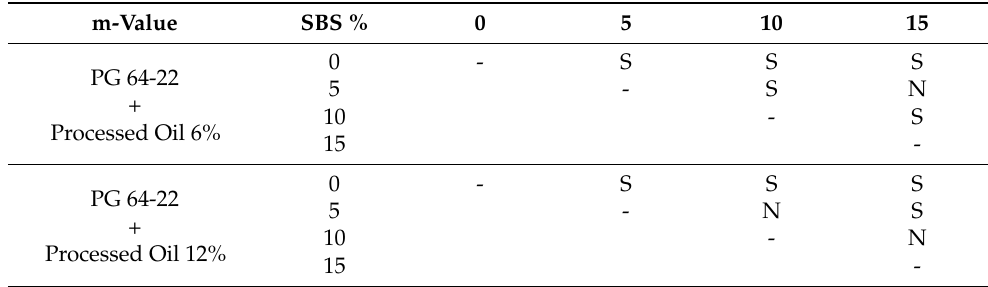
Table 14. Statistical analysis results of m-value for RTFO + PAV aged PG 64-22 with processed oil as a function of SBS content − 24 ◦ C ( α = Table 13. Statistical analysis results of m ‐ value for RTFO + PAV aged PG 64 ‐ 22 with processed oil as a function of SBS content − 12 °C ( α = 0.05).